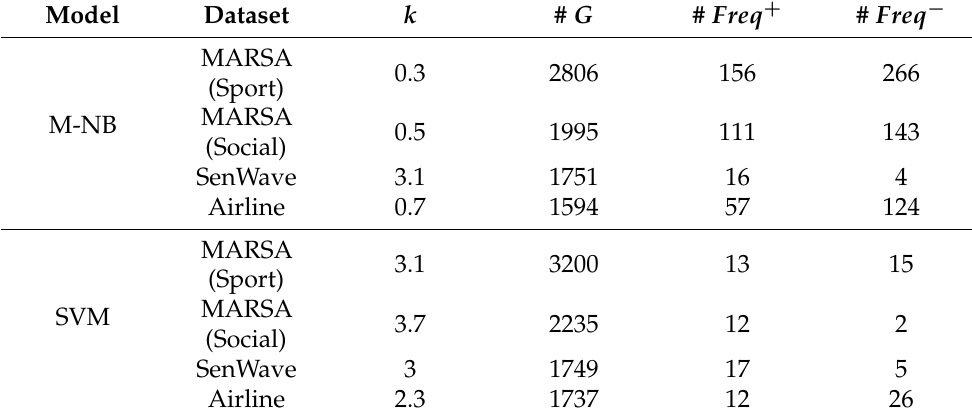
Table 14. Optimal k value and common term distribution for all